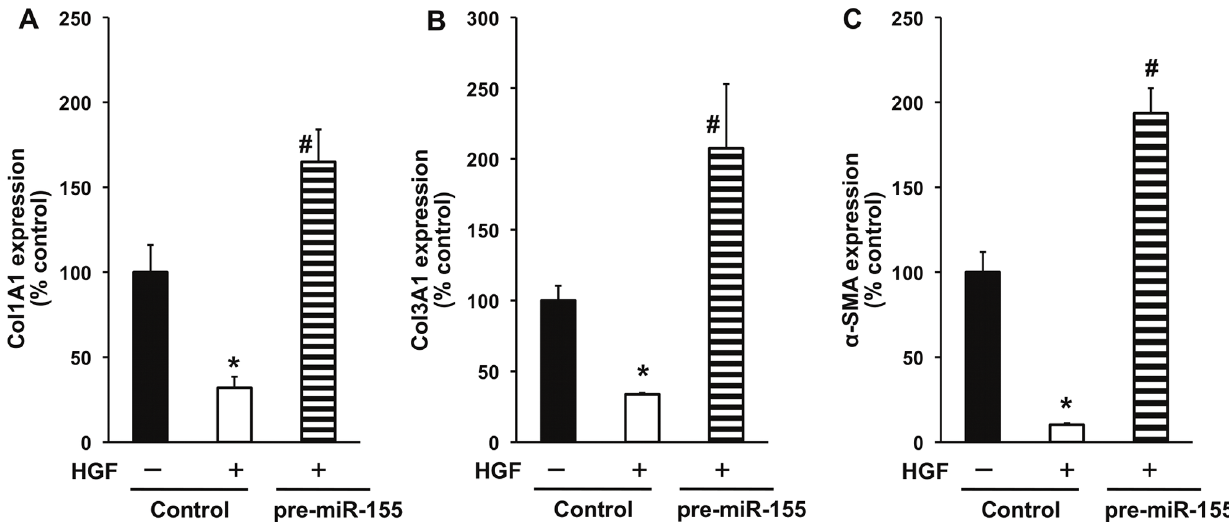
Figure 8. miR-155 over-expression abrogates HGF-induced inhibition of fibrogenic response in mouse cardiac fibroblasts (CFs). CFs were either transfected with miR-155 mimics (pre-miR-155) to over-express miR-155 or with negative control mimics (control), treated with or without HGF under diabetic conditions [TGF- b (10 ug/mL + high glucose (25 mM glucose)] and mRNA expression of fibrogenesis markers like col1A1 ( A ), col3A1 ( B ) and a -SMA ( C ) were measured by qRT-PCR. HGF decreased the expression of above markers. *P , 0.01 versus without HGF. Over- expression of miR-155 nullified the effects of HGF. P , 0.01 versus control-transfected cells. HGF indicates hepatocyte growth factor; Col1A1, collagen type 1 alpha 1; Col1A1, collagen type 3 alpha 1; a -SMA, alpha smooth muscle actin.